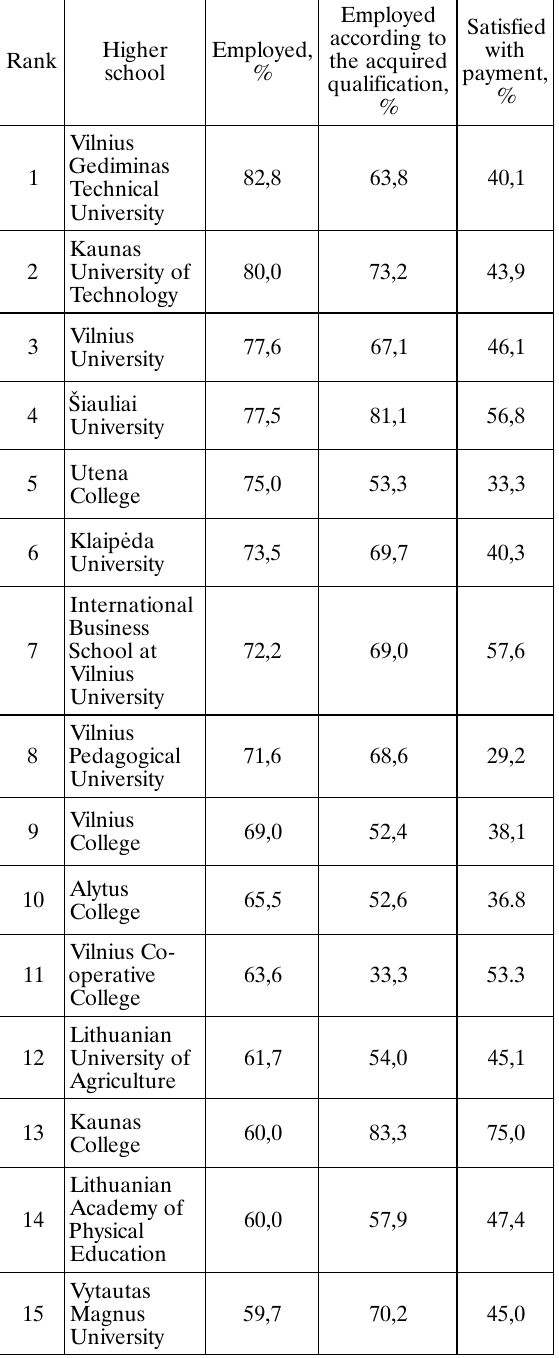
Table 1. Rating of higher schools according to the